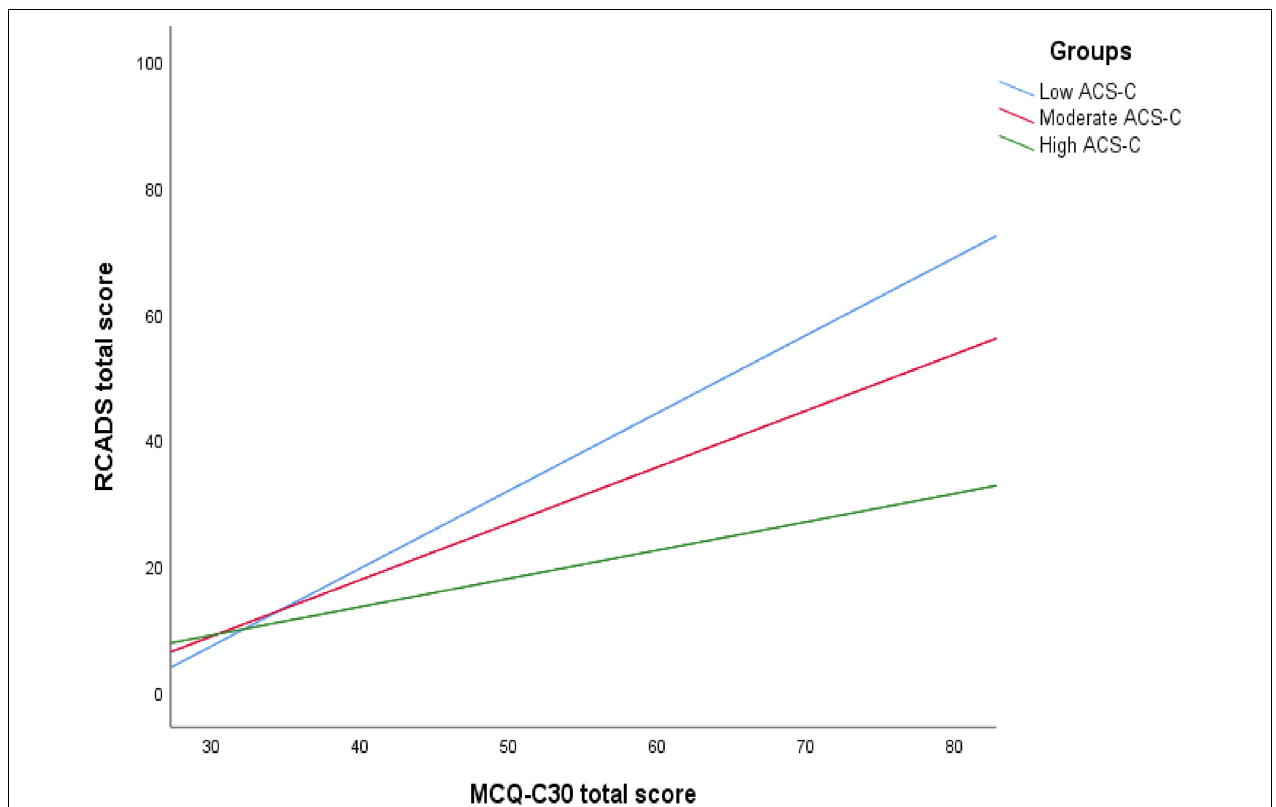
FIGURE 4 | Scatter plot showing the effect of metacognition on symptoms at different levels of attention